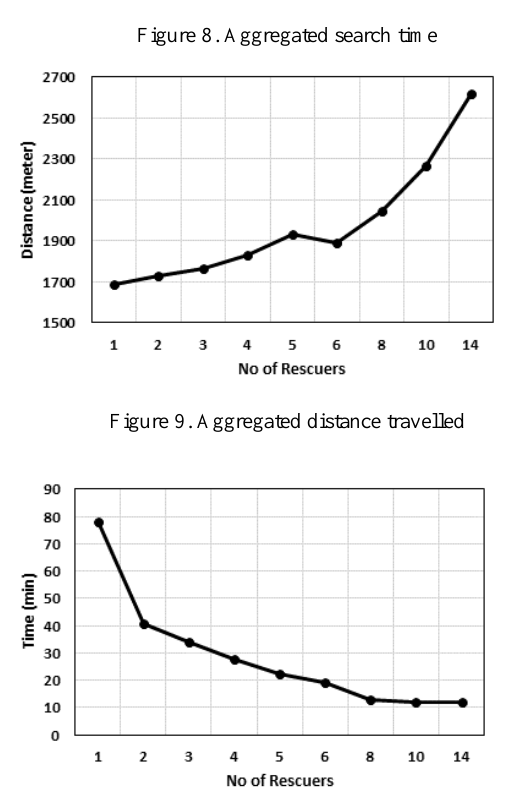
Figure 8. Aggregated search time